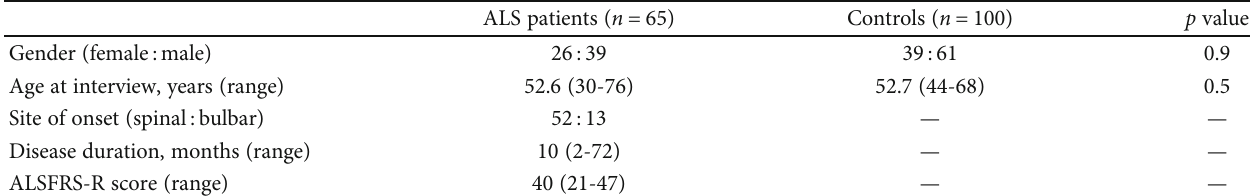
Table 1: Comparison between ALS patients and controls and clinical characteristics of patients with ALS.